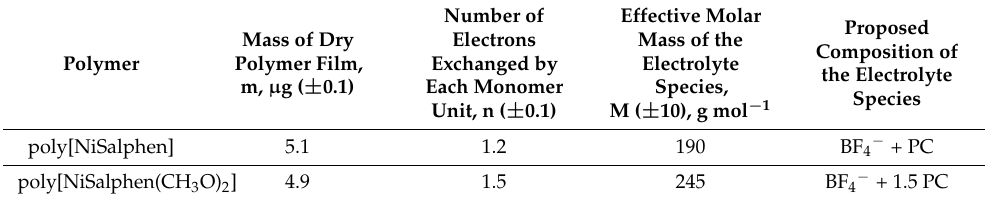
Table 1. The number of electrons exchanged by each repeat unit of the polymer film in the p-doping/dedoping in 0.1 M Et 4 NBF 4 /PC, values of the effective molar mass of the electrolyte species, and their proposed composition. Mass of Dry Polymer Polymer